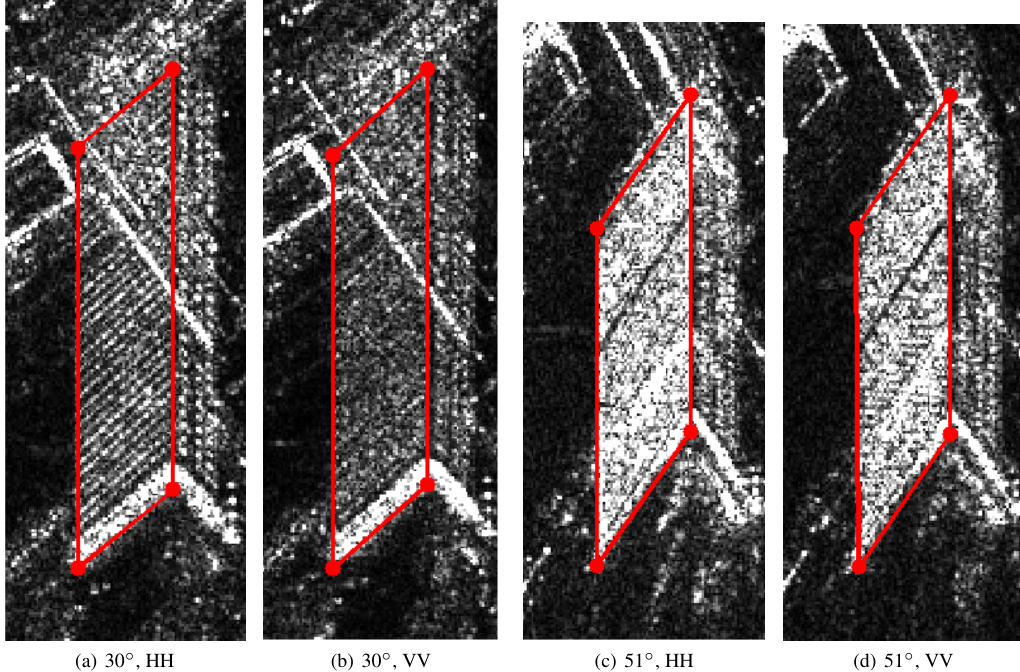
Figure 4. Facade at Alexanderplatz, Berlin. Extracted facade layover areas indicated by red frames. Time difference between HH and VV data takes: 11 days.